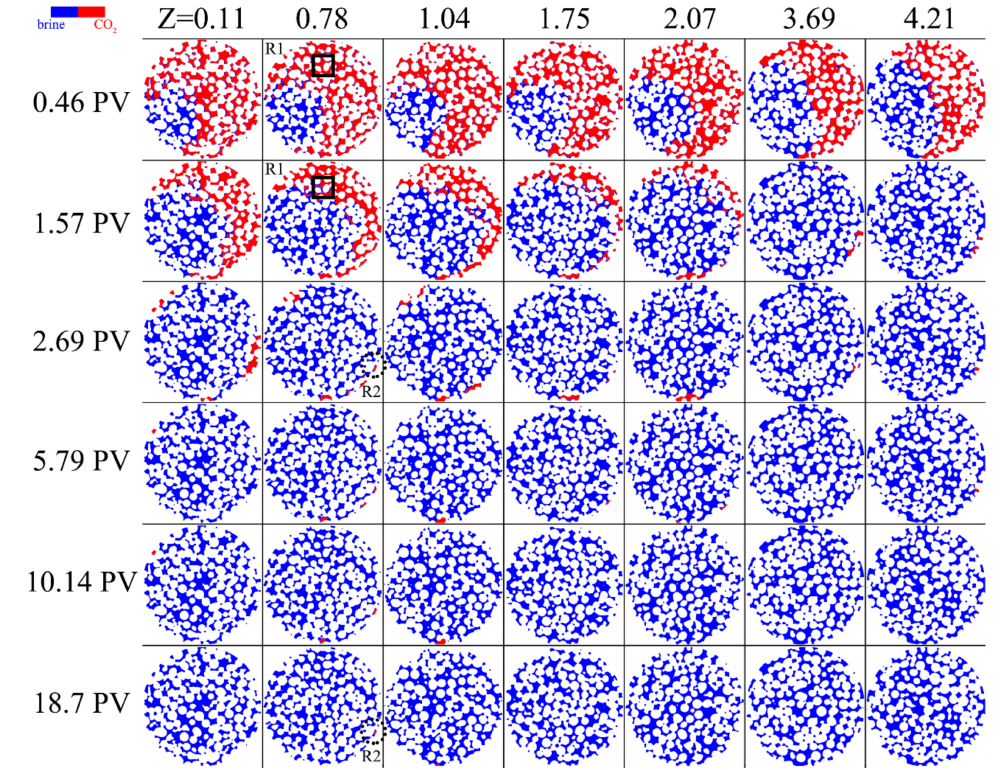
Figure 3. Time-lapse images of gaseous CO 2 (red) at different positions for 0.04